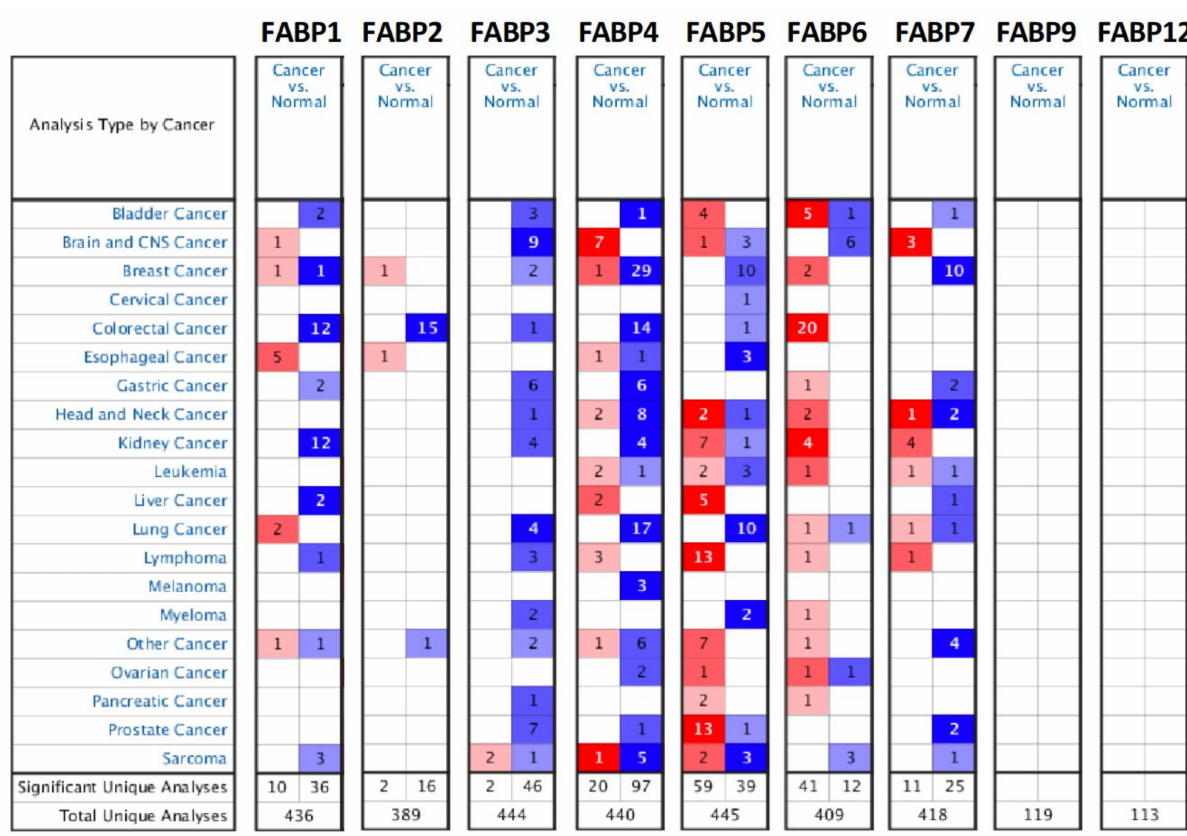
Figure 1. The mRNA expression study of fatty acid-binding proteins ( FABP s) in normal and CRC tissues (Oncomine database). Color gradients represent gene ranking percentiles; a significant level was accepted at p < 0.05, a multiple of change of 1.5, and a gene ranking in the top